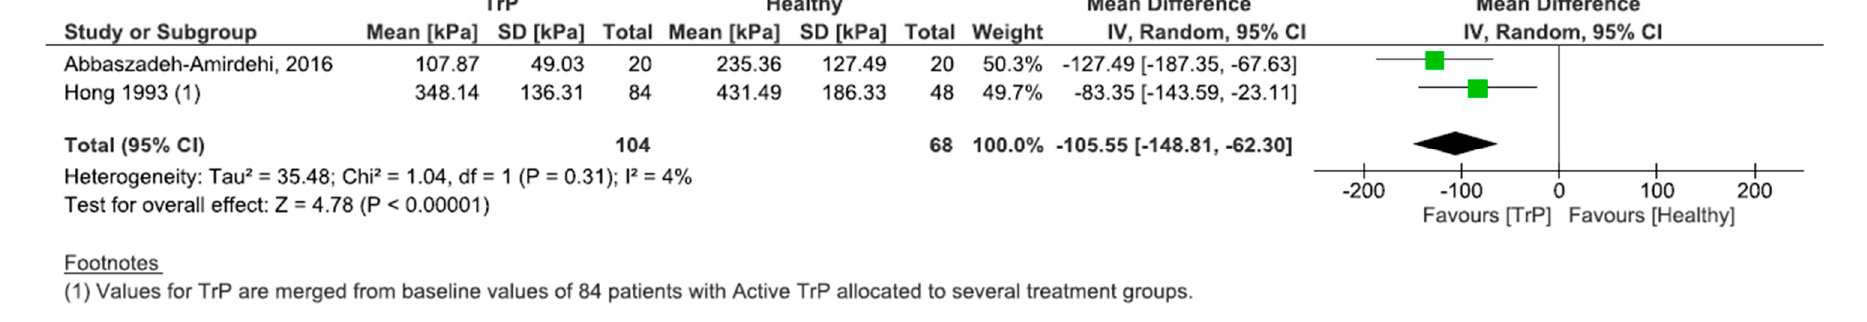
Figure 3. Forest plot for the comparison between patients with active TrPs and healthy controls. Table 5. Summary of findings for the